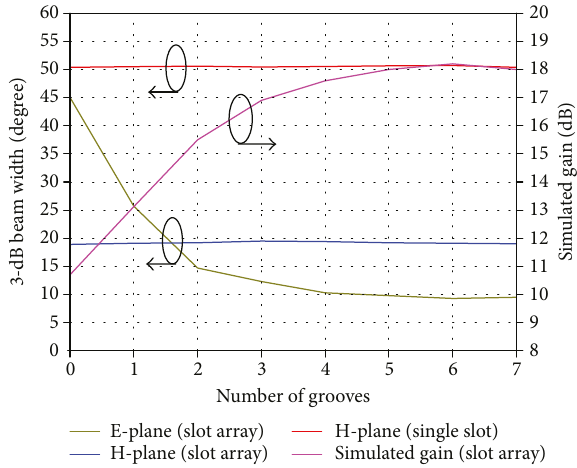
E-plane (slot array) H-plane (single slot) H-plane (slot array) Simulated gain (slot array) Figure 2: 3 dB beamwidth and gain for di ff erent groove numbers in each